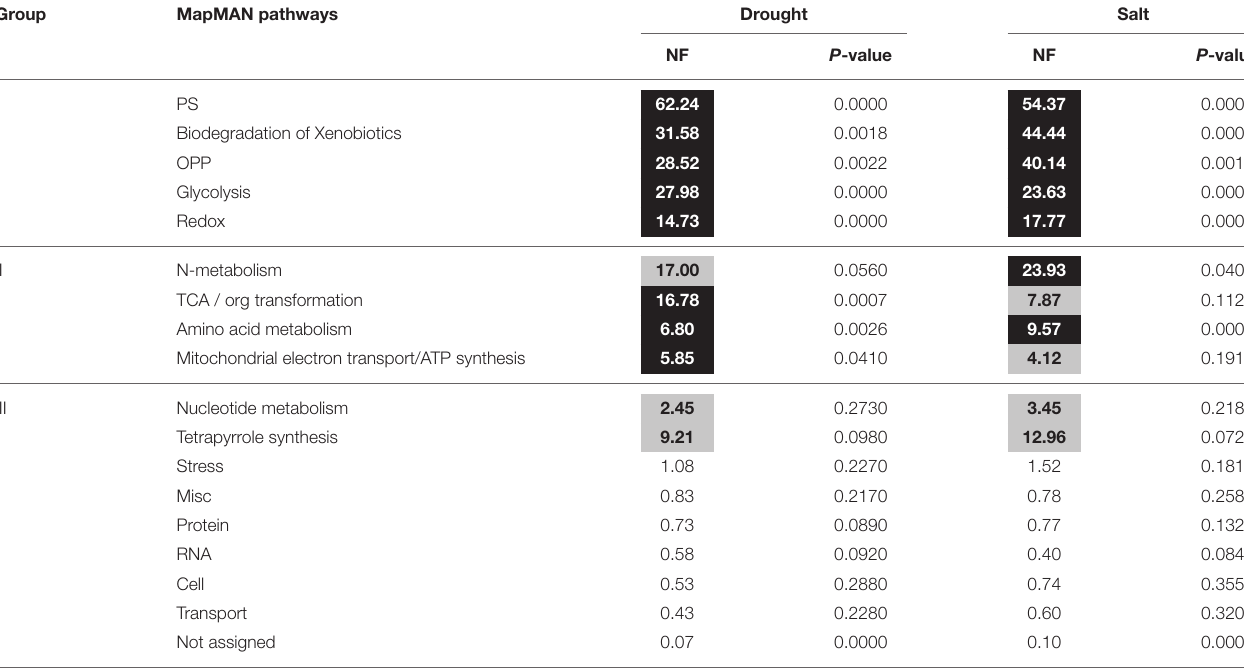
TABLE 2 | Pathway enrichment analysis of proteins changed by drought and salt treatments in bermudagrass. Group MapMAN